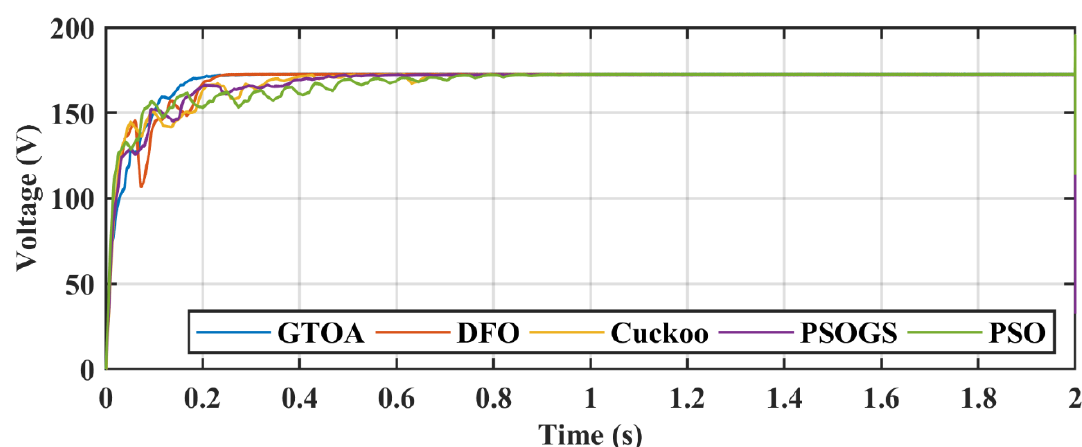
Figure 19. Comparison of voltage transients of GTOA.